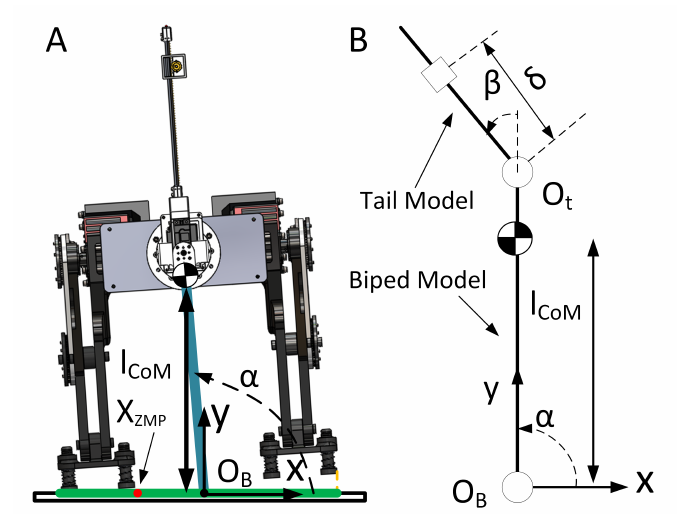
Figure 7. ZMP illustration with simplified mathematical model.( A ) an illusion of the tail robot attached to a biped robot with a tilt angle α . ( B ) a simplified mathmatical model of the Biped Robot-Tail System with a tilt angle α and actuated tail angle β .